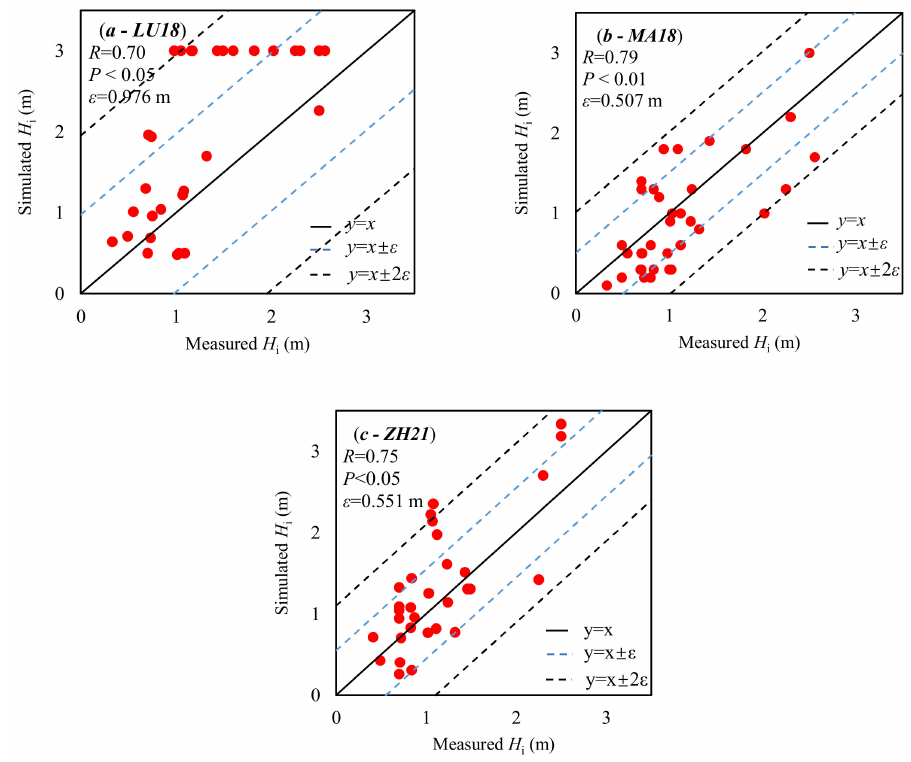
Figure 4. Comparison between the in situ measured H i and the estimations by the above three algorithms under overcast sky conditions. Panel ( a ) is the results for the LU18 algorithm, ( b ) for the MA18 and ( c ) for ZH21. KO20 is absent because it is only available for H p